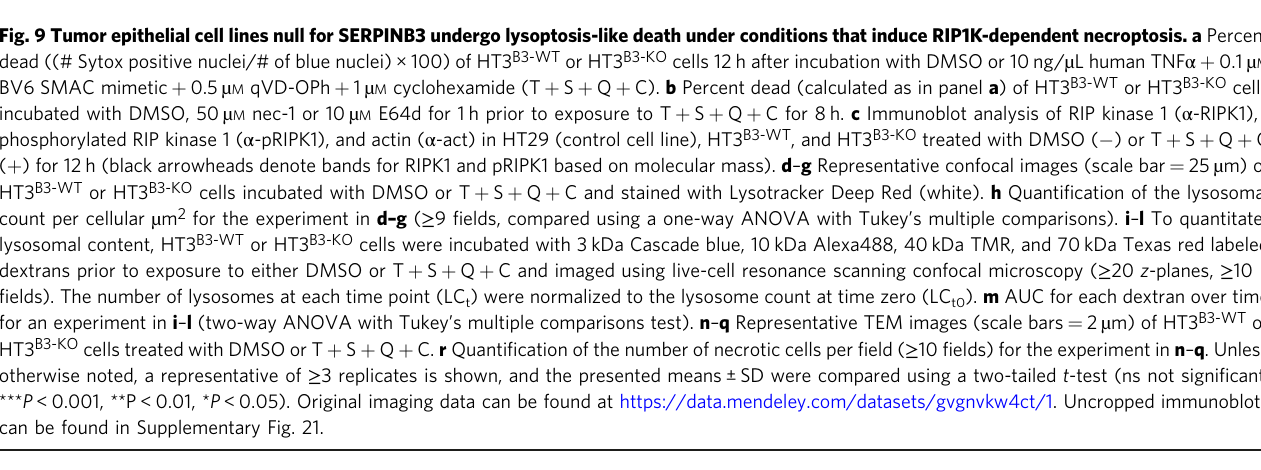
Fig. 9 Tumor epithelial cell lines null for SERPINB3 undergo lysoptosis-like death under conditions that induce RIP1K-dependent necroptosis. a